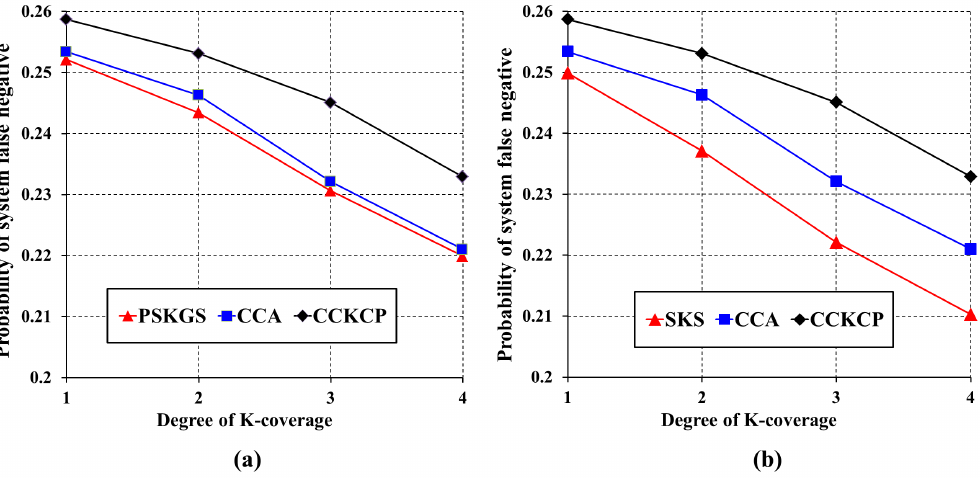
Figure 17. Probability of system false negatives of ( a ) PSKGS, CCA [31] and CCKCP [32] and ( b ) SKS, CCA [31] and CCKCP [32], with the detection threshold θ = 3 and the data aggregation ratio δ =